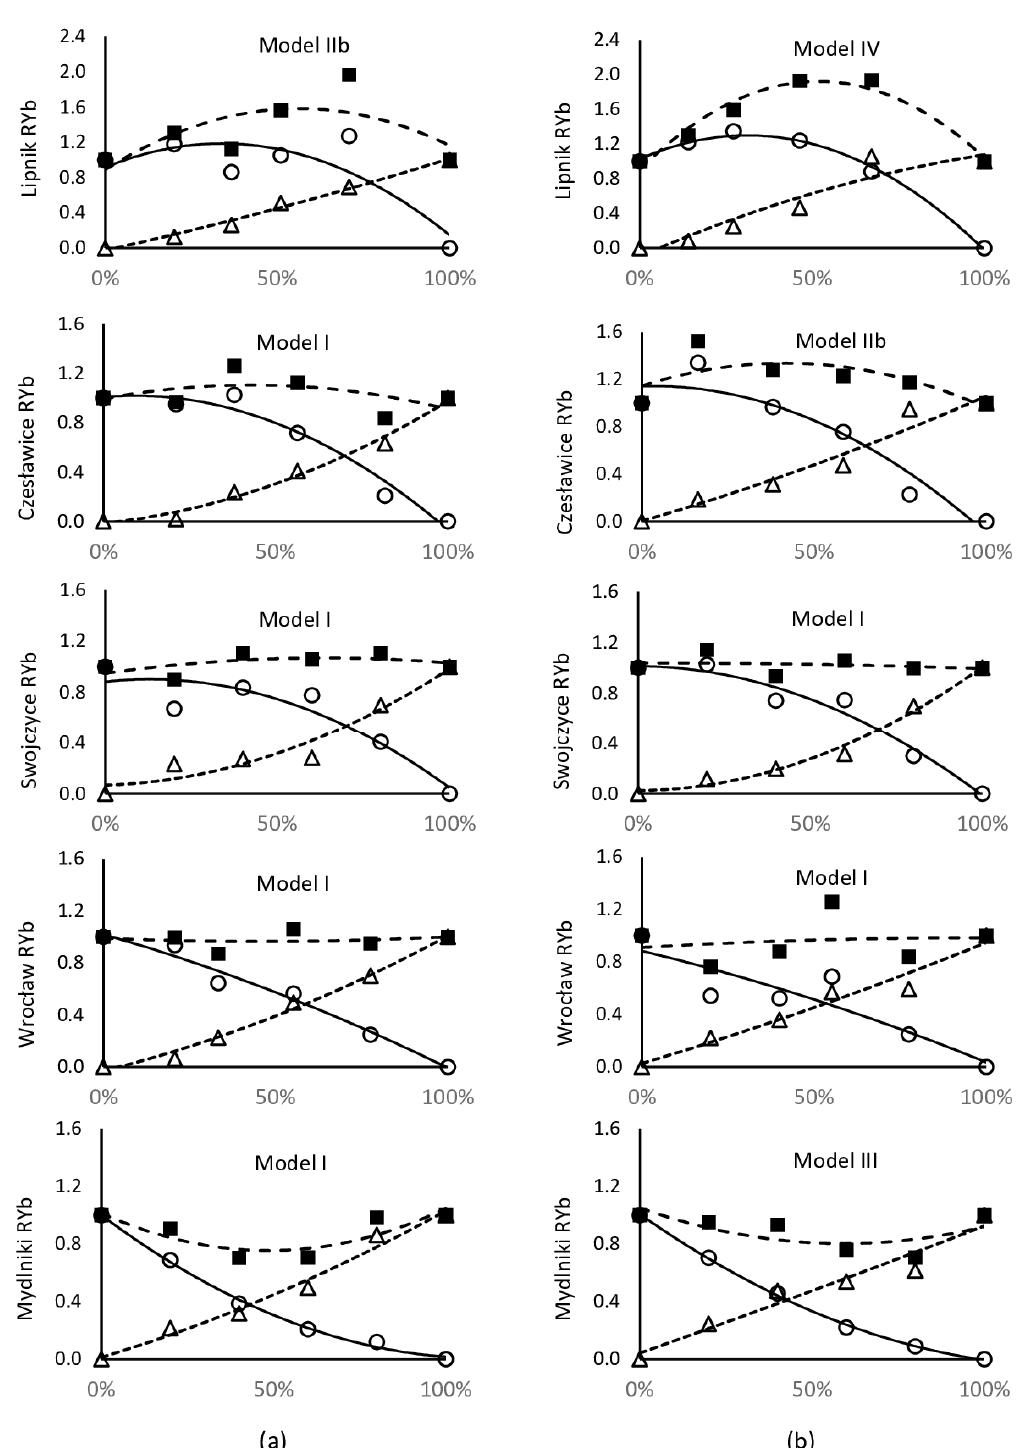
Figure 7. The replacement competition model for the relative biomass yield (RYb) of winter wheat and cornflower (B) in the 2018–2019 season (classified according to the t -test and p < 0.05). ( a ) competition between WW and B resistant (R) and ( b ) competition between WW and herbicide-susceptible cornflower (S). Legend: o—WW; ∆ —R ( a ) or S ( b ), □ —WW + R ( a ) or WW + S ( b ). For the herbicide-susceptible cornflower biotype (S), in as many as four out of five sites, the competitive relationship between WW and B expressed by the number of seeds in the plant (Figure 8, Table S9) showed the same relationship as for biomass. A different